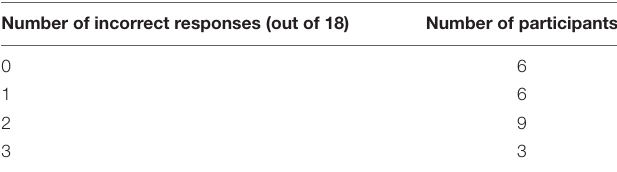
TABLE 10 | Numbers of correct and incorrect responses given by participants. Number of incorrect responses (out of